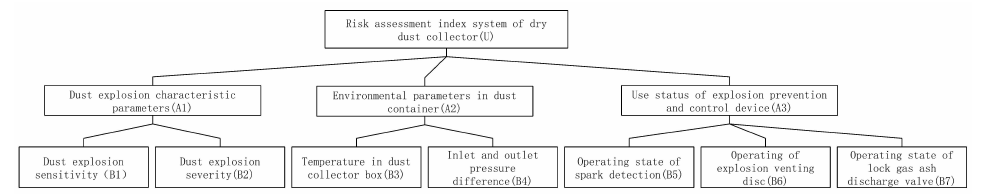
Figure 1. Risk assessment index system for dry dust